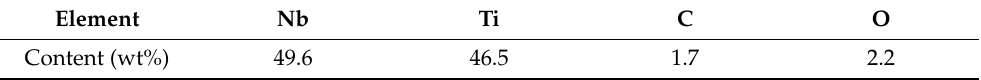
Table 1. Chemical composition of NbTi material measured by energy dispersive spectroscopy (EDS).